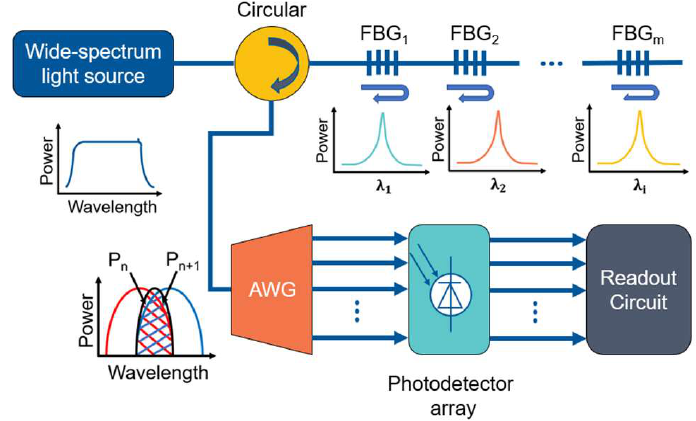
Figure 1. FBG wavelength interrogation system based on AWG.